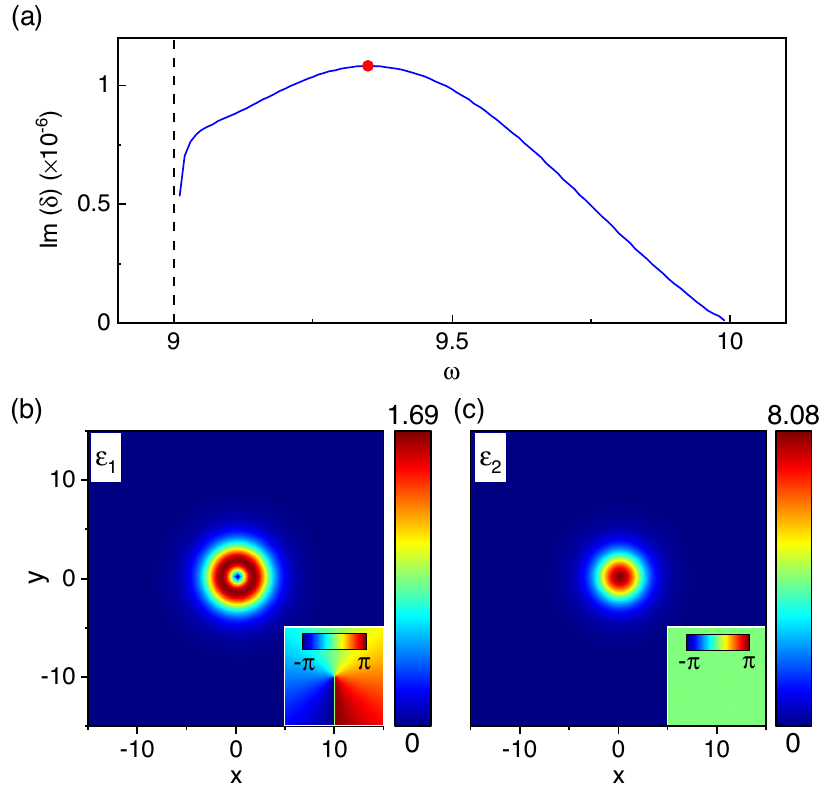
Fig. 5 Stability of the bulk solitons. a Growth rates Im( δ ) for the bulk solitons at different frequencies. The dashed line denotes the lower band edge. b , c The perturbation eigenmodes ε 1 ; 2 with the frequency ω = 9.35, which correspond to the red dot in a . The color bars in b , c denote the amplitudes of the perturbation